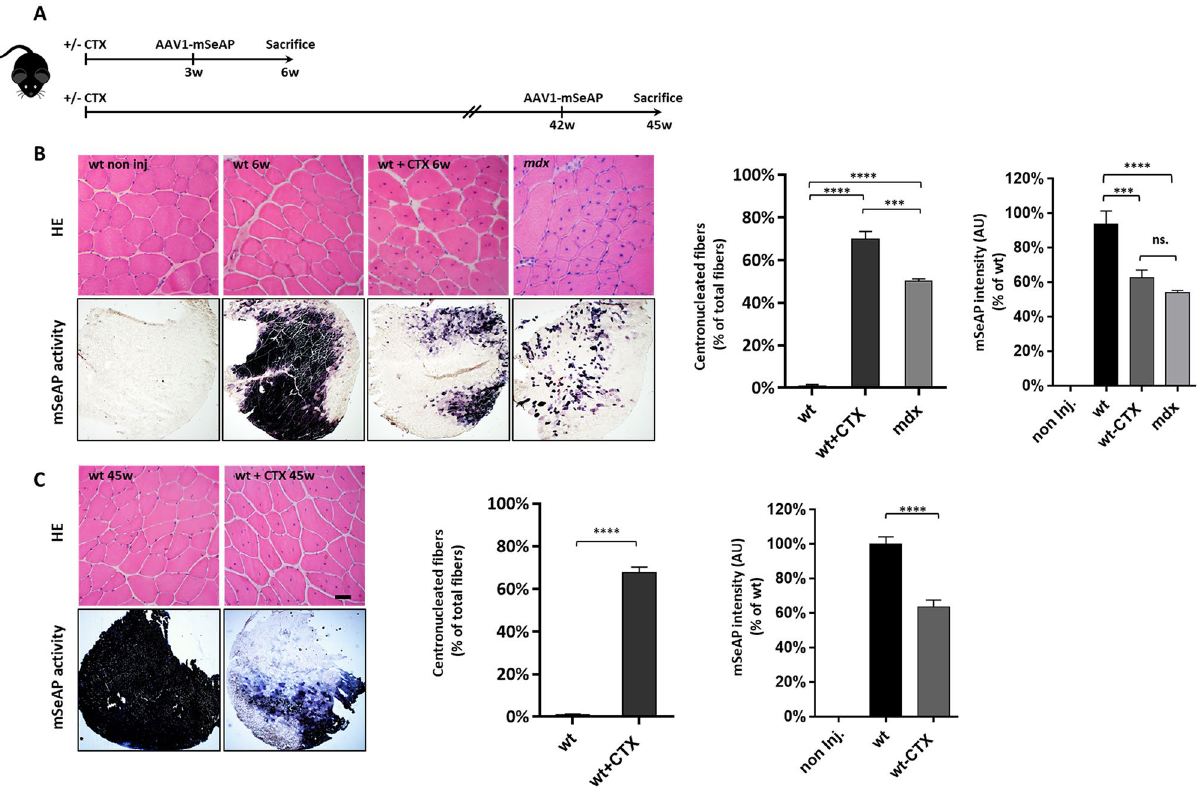
Figure 2. Evaluation of AAV1-mSeAP expression in cardiotoxin regenerated and mdx muscles. ( A ) TA muscles of wt mice were injected or not with 0.5 nmol of cardiotoxin (CTX) to induce muscle regeneration. Three weeks or 42 weeks later, the CTX muscles (wt + CTX), as well as wt muscles (wt) were injected with AAV1- mSeAP vector. Muscles were analysed 3 weeks after vector injection. TA muscles of mdx mice were also injected with AAV1-mSeAP vector and analysed 3 weeks after injection. Wt TAs analysed at 6 weeks = 5, wt + CTX at 6 weeks = 5, mdx = 6, wt at 45 weeks = 5, wt + CTX at 45 weeks = 5. ( B ) Representative (top) haematoxylin and eosin (HE) staining and (bottom) histochemical detections of mSeAP activity in TA transversal sections of non- injected wt (non inj.), wt, wt + CTX and mdx muscles 6 weeks after CTX injury and 3 weeks after AAV1-mSeAP injection. The quantification of the centronucleated fibers expressed as percent of total fibers as well as mSeAP activity is shown. ( C ) Representative haematoxylin and eosin (HE) staining and histochemical detections of mSeAP activity in TA transversal sections of wt and wt + CTX muscles 45 weeks after CTX injury and 3 weeks after AAV1-mSeAP injection. The quantification of the centronucleated fibers expressed as percent of total fibers as well as mSeAP activity is shown. *** p < 0.001, **** p < 0.0001. n.s., non-significant. Scale bar 100 efficiency in wt + CTX muscles, no difference was observed in the total vg copy number in the wt + CTX muscles when compared to wt muscles (Fig. 3A). Only 40% of the genomes were present in mdx muscles, which is coher- ent with the AAV genome loss from dystrophin-deficient muscles that we previously described 13,21 . We next sought to determine the vg intracellular localization. Cell fractionation was performed from wt, wt + CTX and mdx muscles injected with AAV1-mSeAP for 3 weeks, and the vg contents were determined in cytoplasmic and nuclear fractions. GAPDH, the early endosome protein EEA1 and the Golgi protein GM130 were properly enriched in the cytosolic fraction whereas the H3 histone was enriched in the nuclear fraction, thereby validating the fractionation procedure (Fig. 3B). The vg proportion in the nuclear fraction was around 80–90% of total vg in the three conditions (Fig. 3C). Altogether, these results suggest a normal virus entry and viral genome maintenance in the CTX-mediated regenerated muscles. A similar amount of vg number in wt + CTX and wt muscles was also measured 45 weeks after CTX injection (Fig. 3D). Overall, viral genome entry into the muscle fibres, intracellular trafficking resulting to nuclear localization of the viral genome and maintenance of the viral genome appeared unchanged in the CTX-mediated regenerated muscles despite reduced transgene expression. AAV genomes are not properly transcribed in CTX regenerated and mdx myofibers. We then evaluated the viral genome transcription in the regenerated muscles. mSeAP pre-messenger (pre-mRNA) and messenger RNA (mRNA) numbers per vg were quantified by RT-qPCR in wt + CTX and mdx muscles and compared to wt muscles 3 weeks after AAV injection and six weeks after CTX injury (Fig. 4A). The amount of both RNA species per vg was drastically reduced in wt + CTX (17.4 and 6.3%) and mdx (40.0 and 7.8%) muscles compared to wt. Additionally, in mdx muscles, mSeAP mRNAs were significantly fivefold less abundant than their pre-mRNAs probably due to the mRNA instability in mdx muscles previously described 22 . The low amount